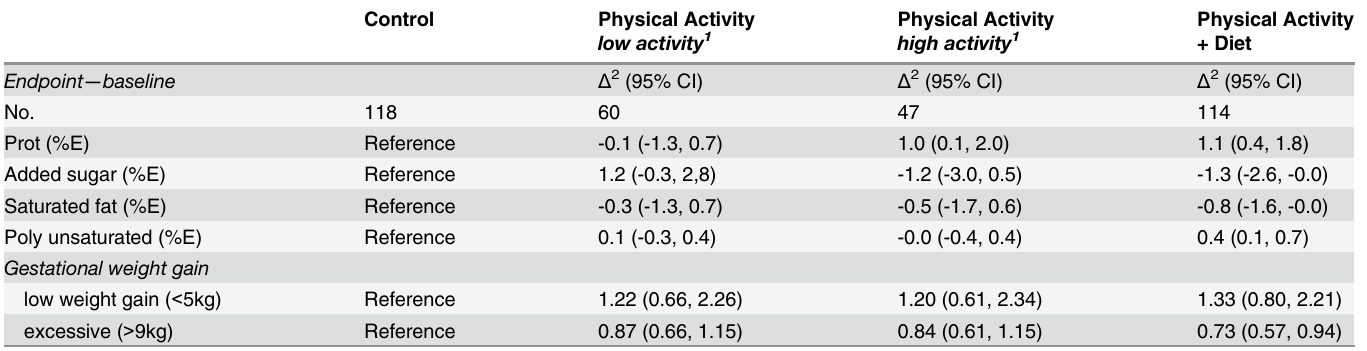
Table 3. Dietary changes in the physically activity intervention groups stratified by median pedometer output in week 17 of gestation. Correspond- ing changes in GWG are also presented.